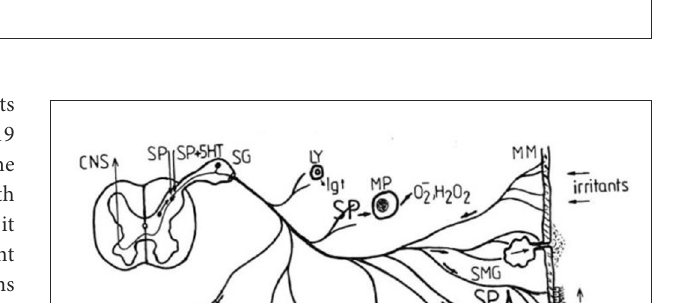
FIGURE1 Model for different information in Substance P sequences (8).